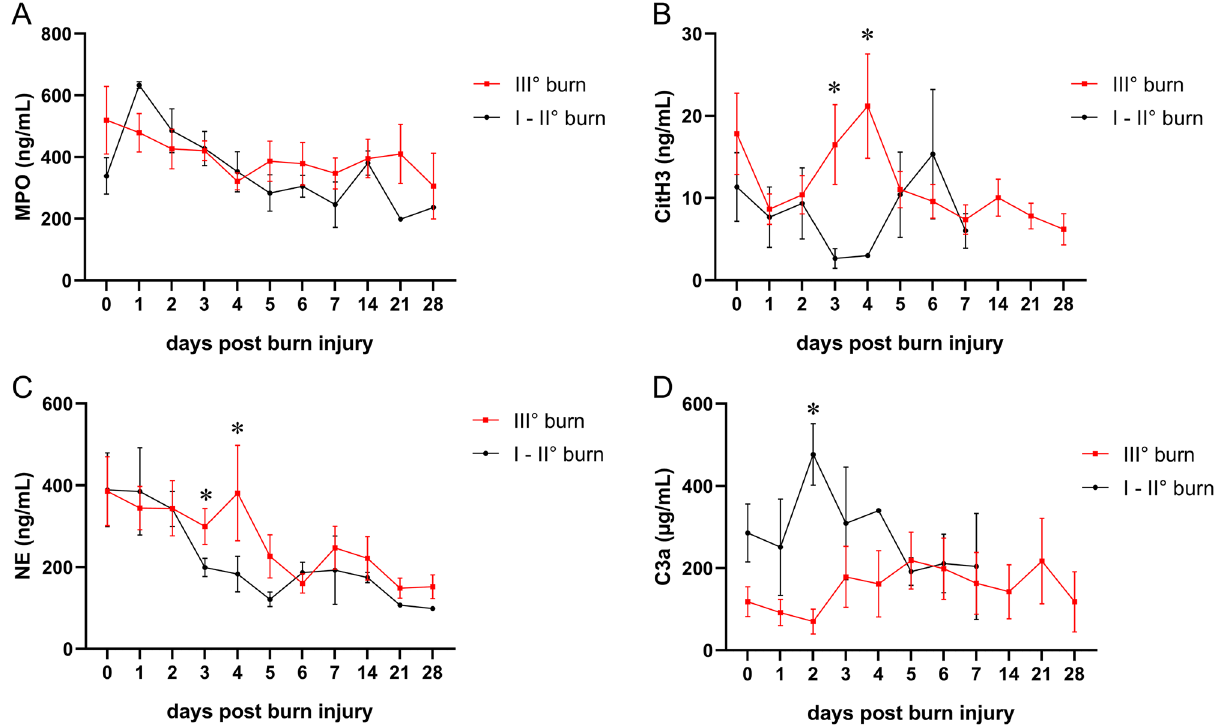
Figure 3. Increased levels of neutrophil-derived factors and C3a in higher degree burns. Serum concentrations of ( A ) MPO, ( B ) CitH3, ( C ) NE, and ( D ) C3a in 3rd degree burn victims (n = 7–15) compared to lower degree burns (n = 1–6). Data are presented as means ± s.e.m. * indicates p values <